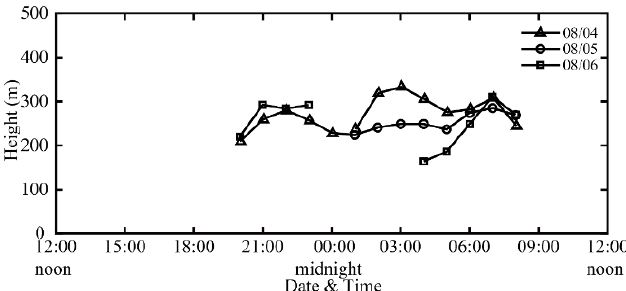
Figure 4. Flow chart for calculating ℎ including 5 steps. Step 1: assuming 𝑁 = 0 , ℎ 𝑎 is calculated with given 𝜏 ∗ , 𝐹 ∗ and 𝑓 ; step 2: 𝜏 and 𝐹 𝜃 at each z- level height (z = 50, 100,…, 400 m) are esti- mated with ℎ 𝑎 , 𝜏 ∗ , 𝐹 ∗ and 𝑧 ; step 3: calculating 𝐿 𝑀𝑂 at z- level heights using 𝜏 , 𝐹 𝜃 and 𝛽 𝑏 ; step 4: based on 𝑈(𝑧) , 𝜏 and 𝐿 𝑀𝑂 , calculating 𝑁 at z-level heights and taking the minimum value of 𝑁(𝑧) ; step 5: substitute 𝑁 into Equation (2) in the first step, and the ℎ can be determined ulti- mately.